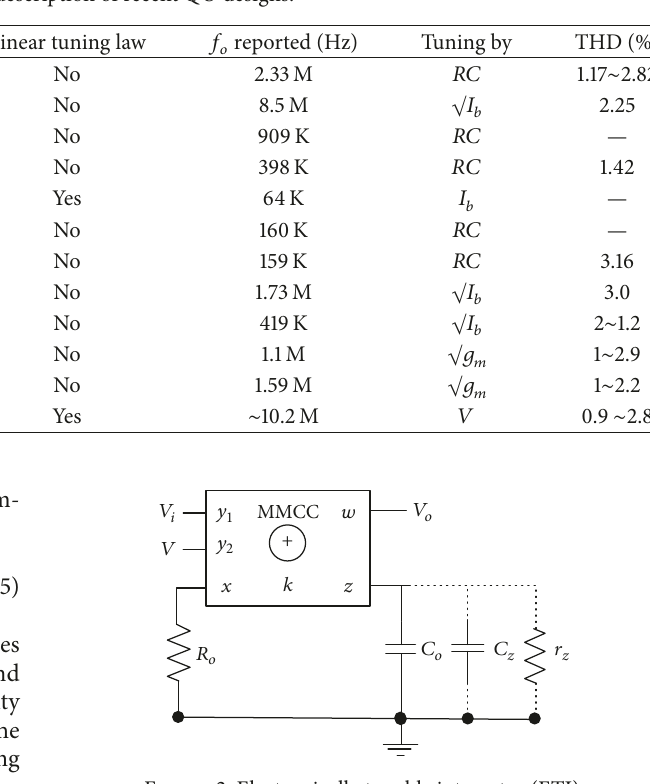
Figure 2: Electronically tunable integrator